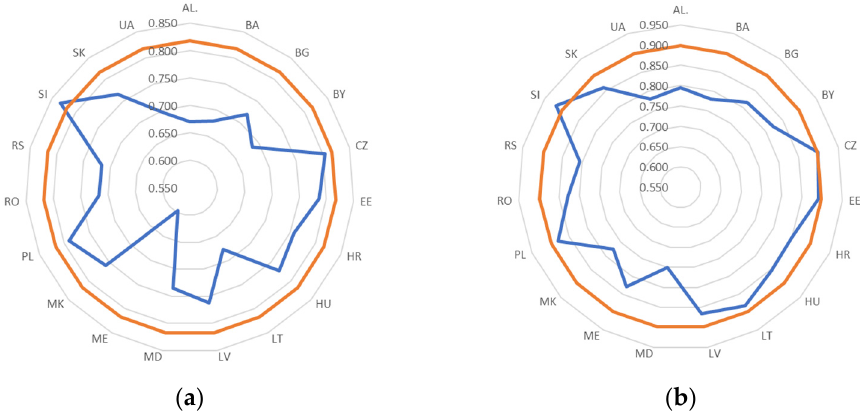
Figure 2. HDI index for EU-28 and CEE countries in ( a ) 2000 and ( b ) 2019. Red line—HDI in EU-28, blue line—HDI in EEC countries.